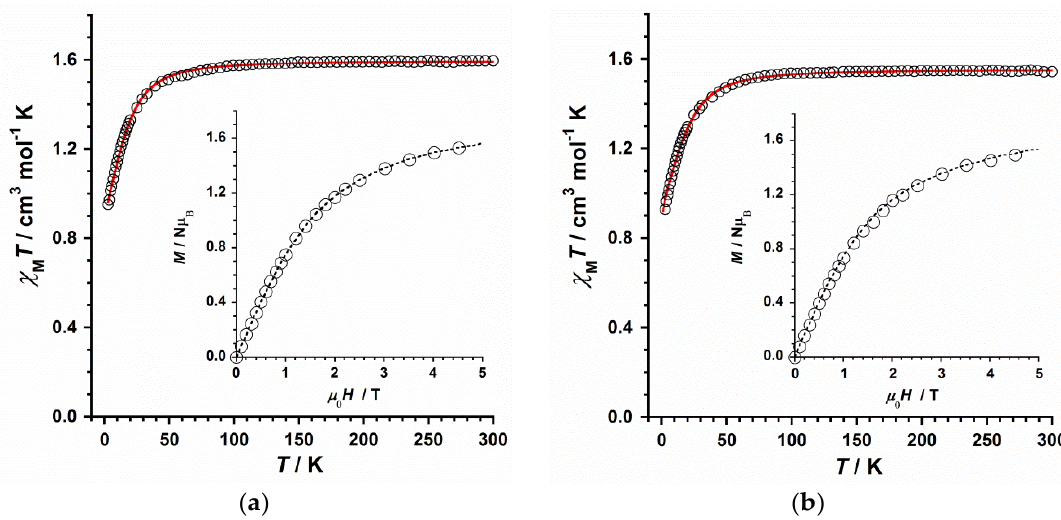
Figure 3. Thermal variation of the χ M T product for 1 ( a ) and 2 ( b ). The solid red line represents the theoretical fit of the experimental data and the inset shows the M versus H plot at 2.0 K obtained for 1 and 2 , the dashed line being a guide to the eye.